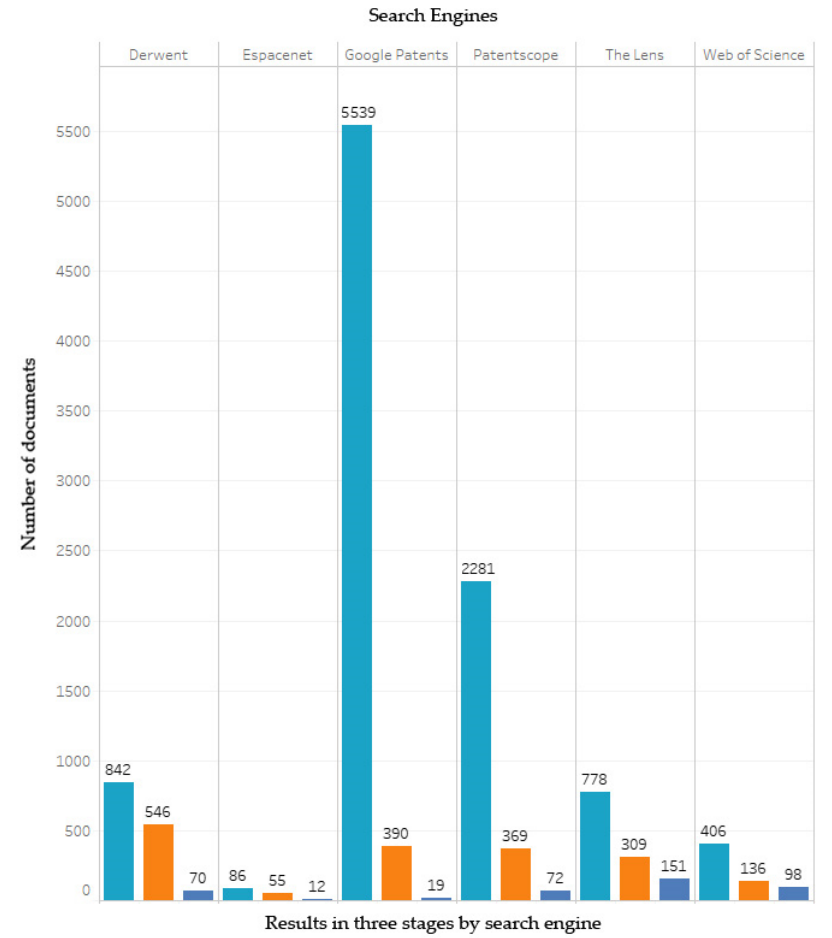
Figure 2. Search method for patents/scientific documents and total results.